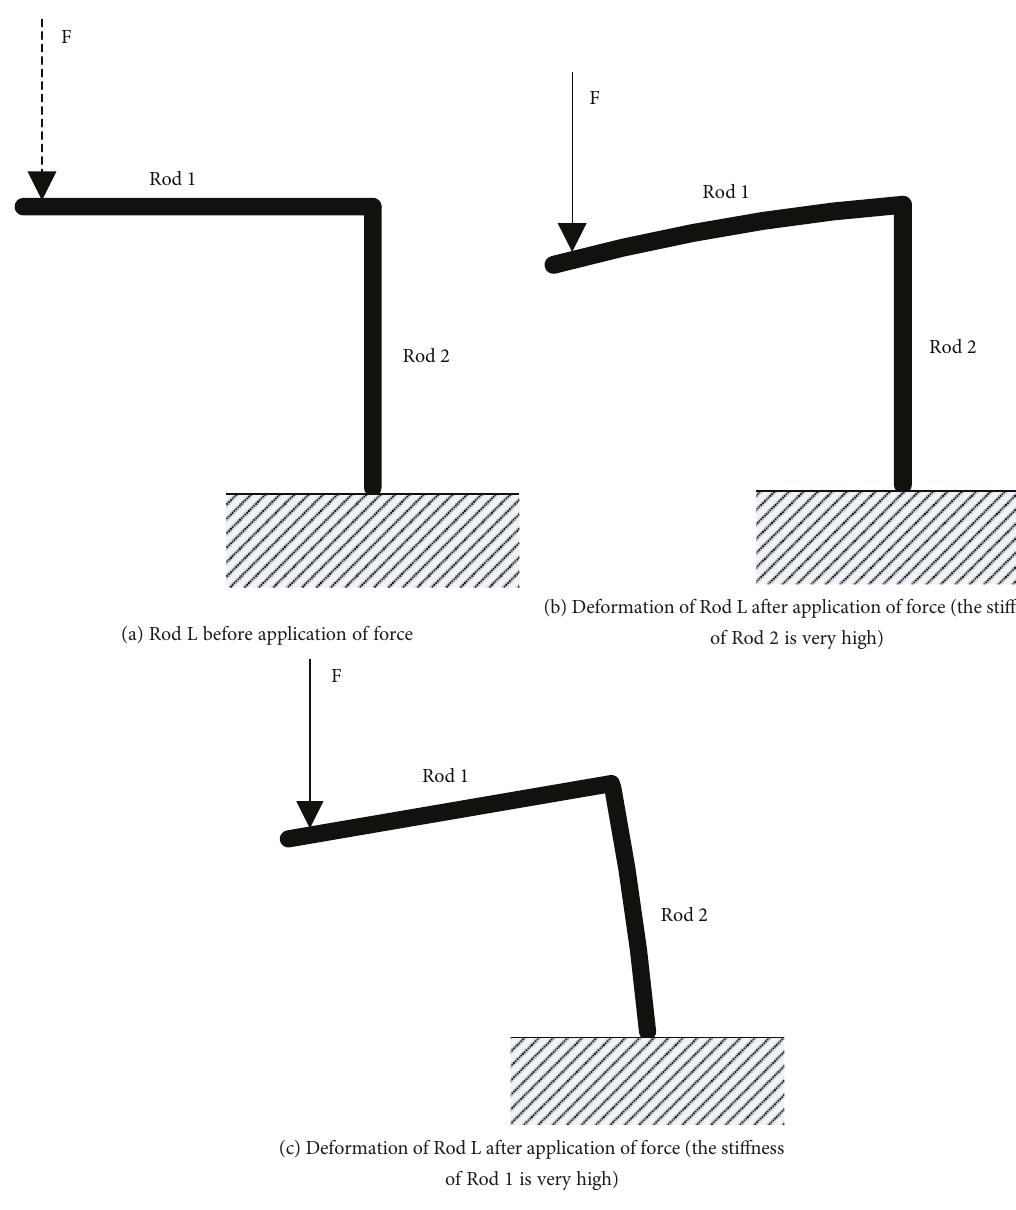
Figure 20: Deformation of Rod L.